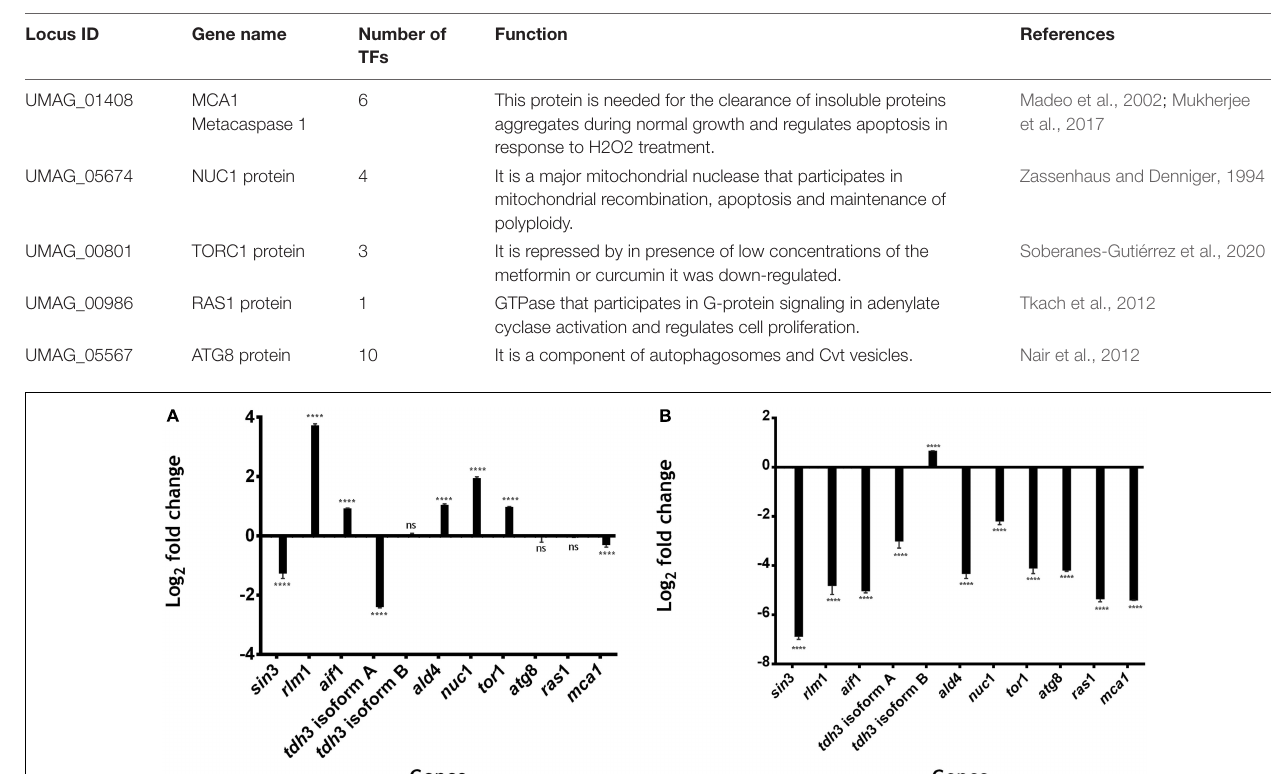
TABLE 6 | Genes related to cell death.